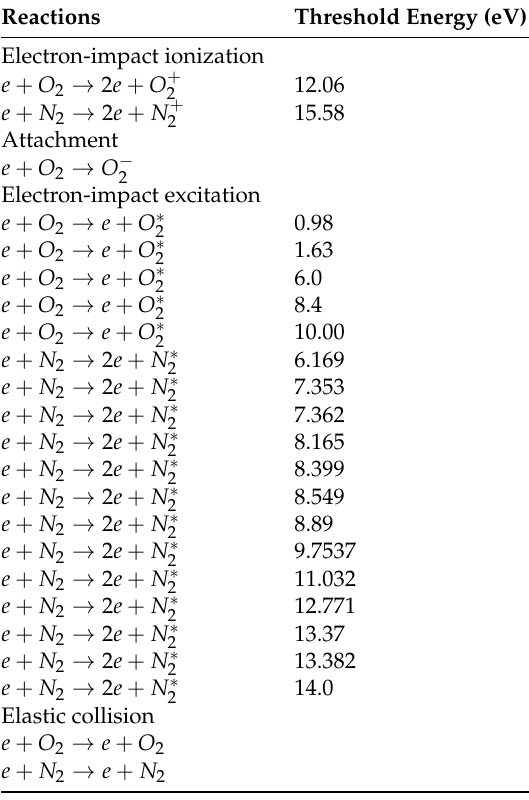
Table 1. Reaction set of a N 2 /O 2 gas mixture used in the model, as well as the threshold energy for electron impact ionization and excitation collisions. The cross sections for all reactions are adopted from Refs. [41–44], and are downloaded from the LXCat database